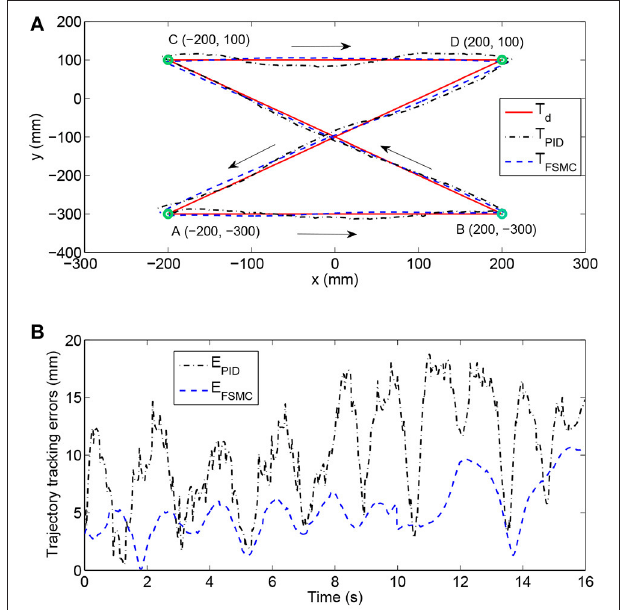
FIGURE 5 | Experimental results of position tracking tests with different control schemes. (A) The comparison among desired trajectory, the trajectory with PID controller, and the trajectory with fuzzy sliding mode controller (FSMC). (B) Time histories of position tracking